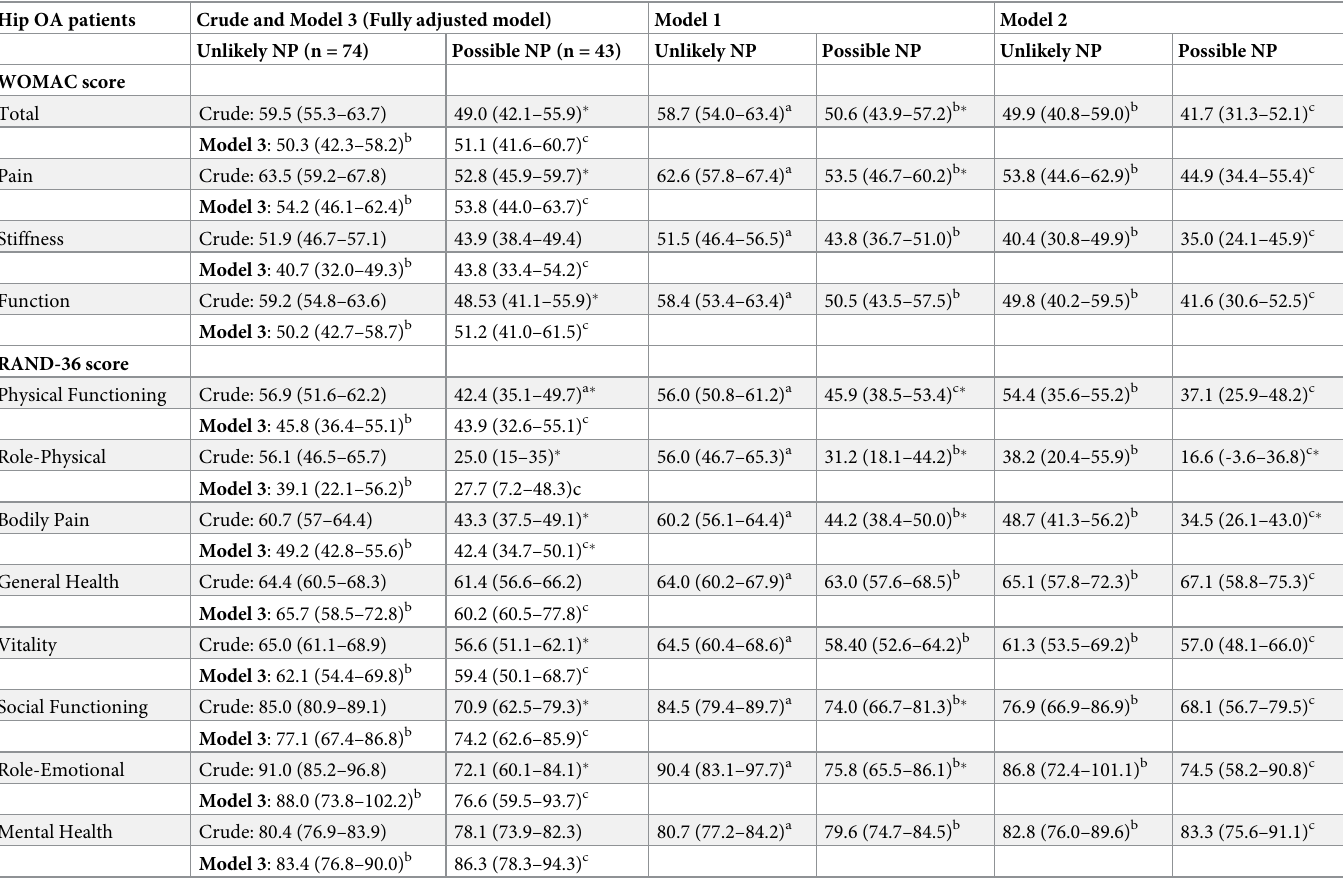
Table 2. Hip OA crude and stepwise ANCOVA adjusted WOMAC and RAND-36 scores § . Hip OA